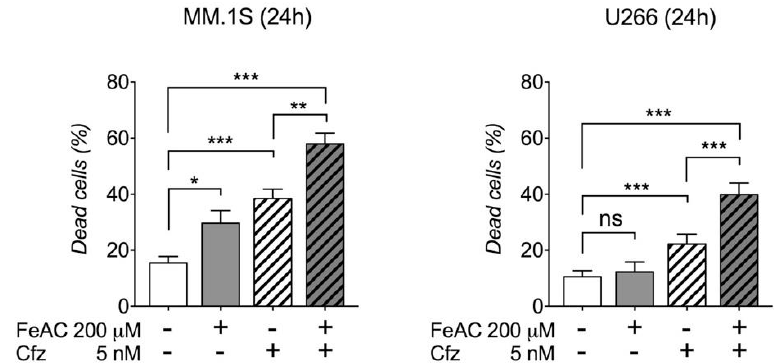
Figure 4. Iron increases carfilzomib efficacy in MM cell lines . Percentage of dead cells measured in MM.1S and U266 cell lines subjected to 200 μM ferric ammonium citrate (FeAC) or 5 nM carfilzomib (Cfz) or combination for 24 h. Values are shown as mean ± standard errors of at least 4 independent experiments for each cell line. Statistical differences were determined by Tukey post-ANOVA test. ns: non-statistically significant. * p < 0.05; ** p < 0.01. *** p < 0.001.